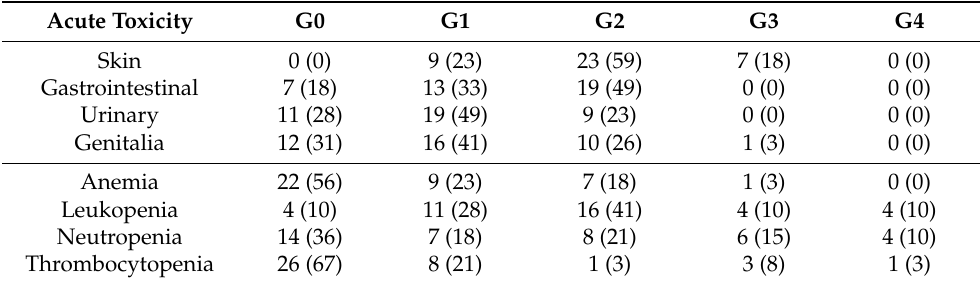
Figure 1. Acute hematologic toxicity during and after treatment. Table 3. Acute toxicity